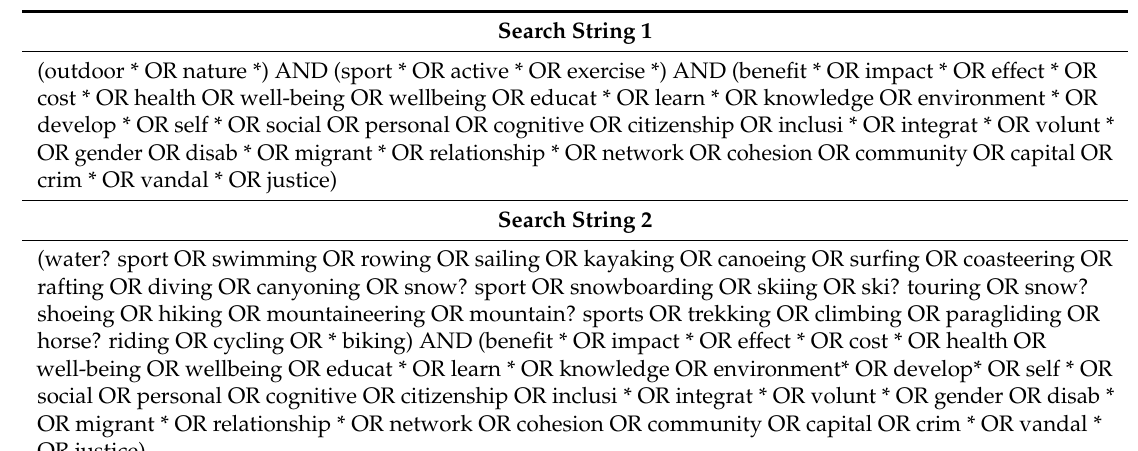
Table 2. Search string formulas